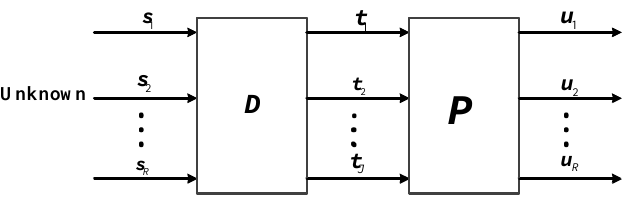
Figure 3. The typical model of blind source separation (BSS).